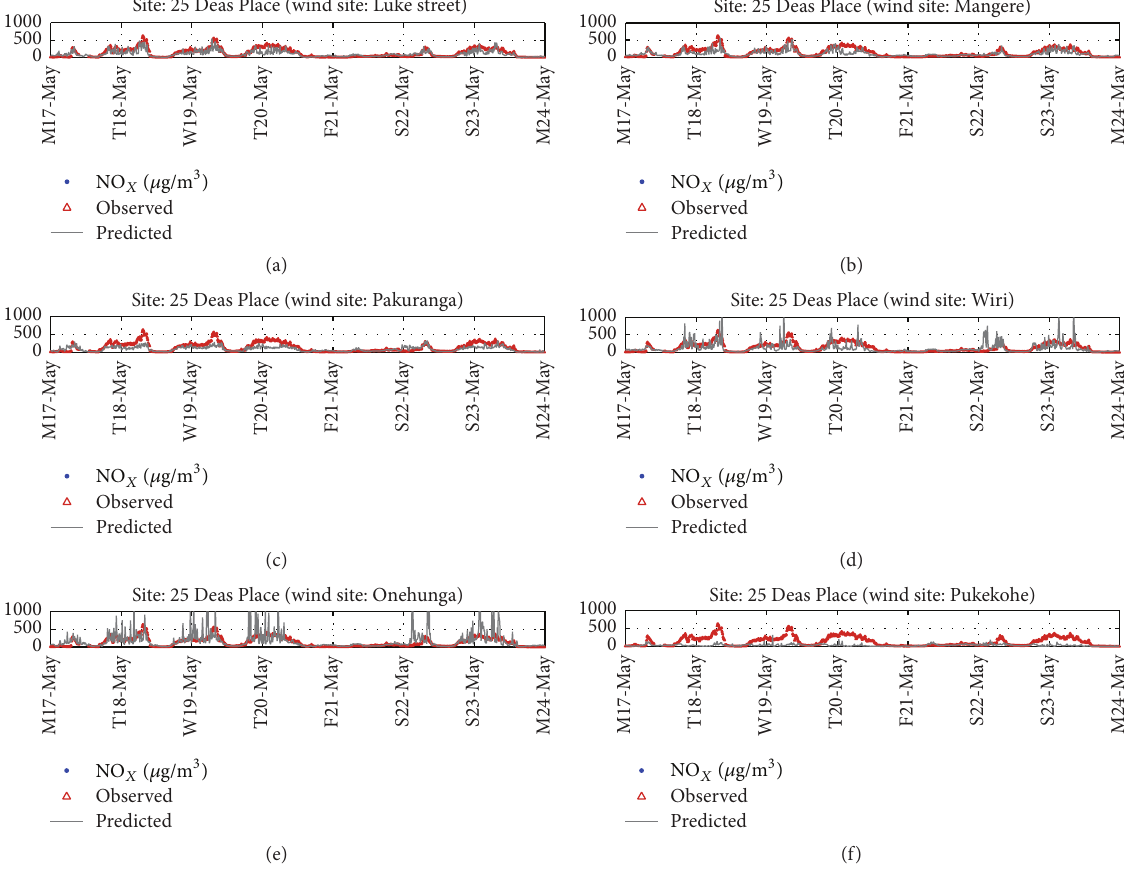
Figure 5: The SOSE model results in predicting one week of NO 𝑋 concentration levels at 25DP using wind data from different wind sites; (a)